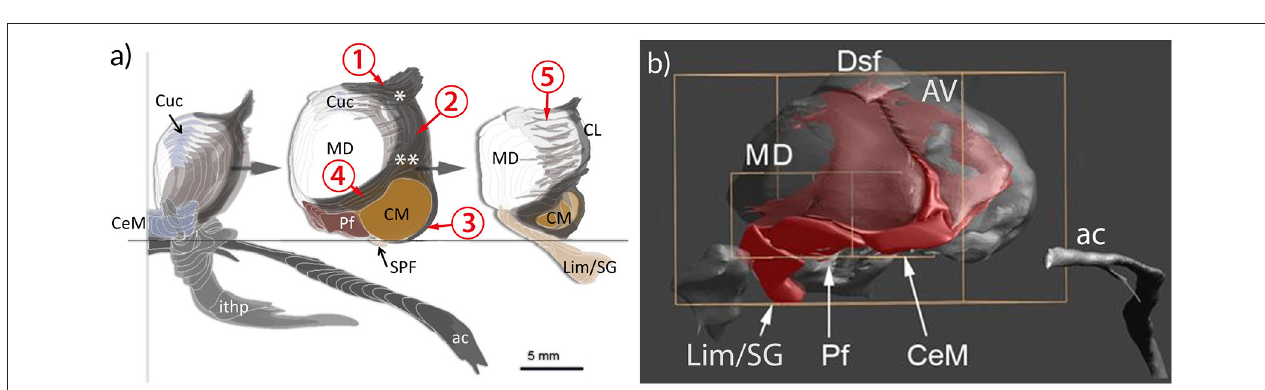
FIGURE 6 | Representation of the intralaminar formation (IL) in relation to the mediodorsal nucleus (MD) and the anterior commissure (ac) and the inferior thalamic peduncle (ithp) as orientation marks. (a) MD is sliced to show the anterior, middle and posterior divisions of IL separately. The core of the formation is represented by the portion nestling around the lateral perimeter of the MD and separating the medial from the lateral region of the thalamus. This central portion bifurcates anterodorsally (asterisk) to form the shell below the anterodorsal region. Ventrally the internal lamina also bifurcates (double asterisk) to form a cap that bounds the centromedian nucleus (CM) and then continues around the anterior pole of MD. Cells within the branching areas are the central lateral nucleus (asterisk) and the paracentral nucleus (double asterisk). At the anterior and posterior pole of the MD the internal medullary lamina enlarges and differentiates as central medial nucleus (CeM) anteriorly and as suprageniculate and limitans nuclei (Lim/SG), respectively. (b) Medial view of a reconstruction of the IL (red). The IL extends along the ventral surface of MD, represented by the central medial nucleus (CeM), parafascicular nucleus (Pf) and Lim/SG. 1–5: divisions of the IL; 1, superior part; 2. central (lateral) part; 3, circumcentral part (lamella intermedia, Schnopfhagen, 1877; lamella praesemilunaris; Hassler, 1982); 4, anterior part; 5, posterior part (retrocentral part); Cuc, cucullar nucleus.